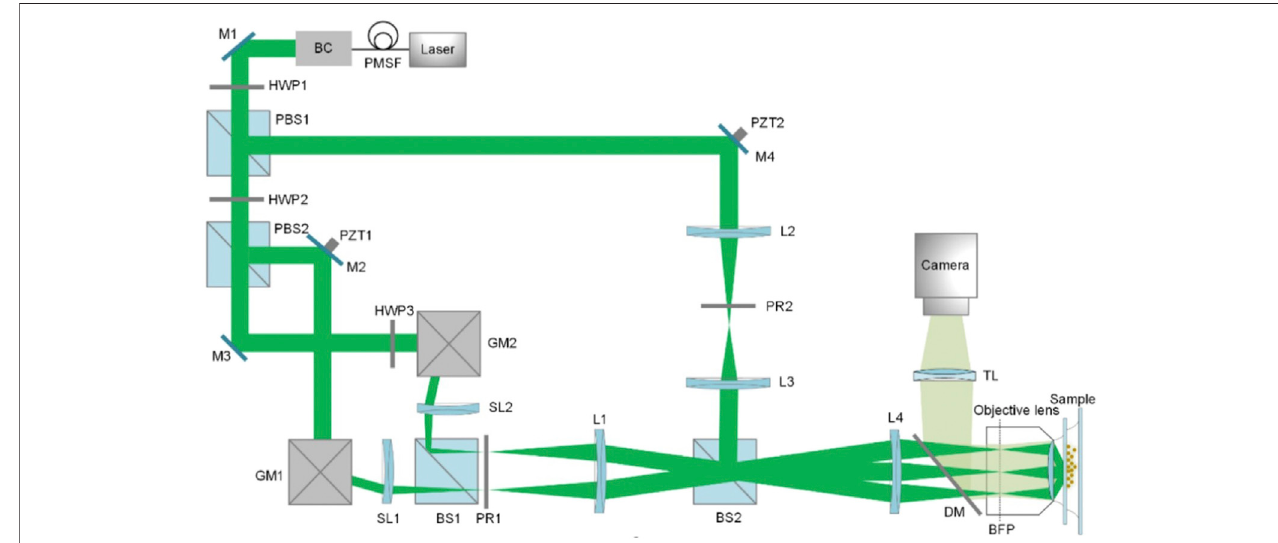
FIGURE 3 | The diagram of 3D galvanometer-based SIM [31]. PMSF, polarization-maintaining single-mode fi ber; BC, beam collimator; PBS, polarized beam splitter;GM, scanninggalvanometer; PZT, piezoelectric stage; SL, scanninglens; PR,polarization rotator; BFP, back focalplane; DM,dichroicmirror;TL, tube lens. The fi gure is modi fi ed with permission from Ref. (31). Copyright © 2019 The Optical Society.